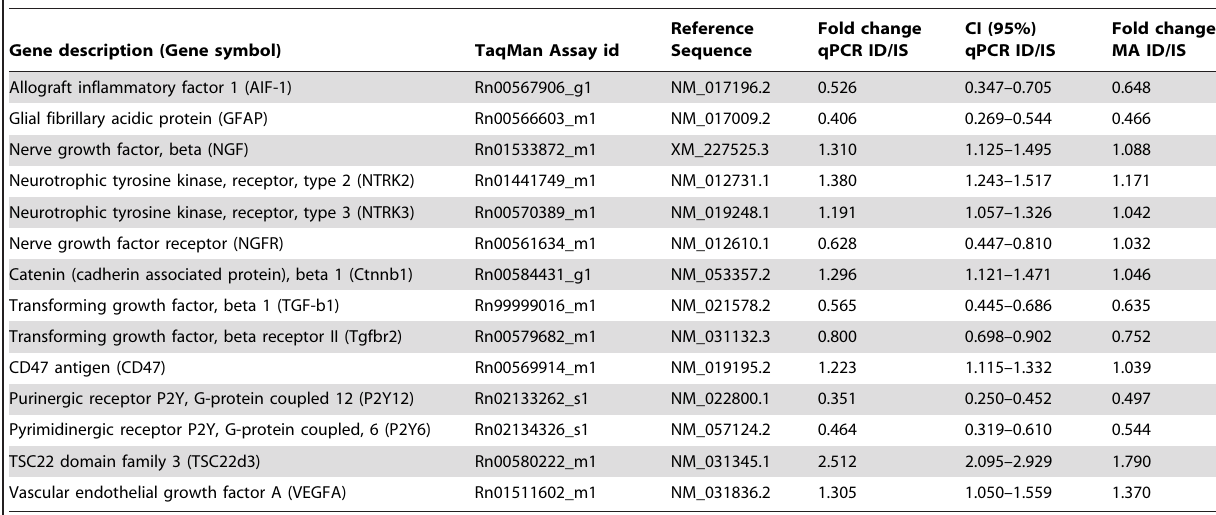
Table 2. Results of the significantly regulated genes on TaqMan Low Density Arrays.